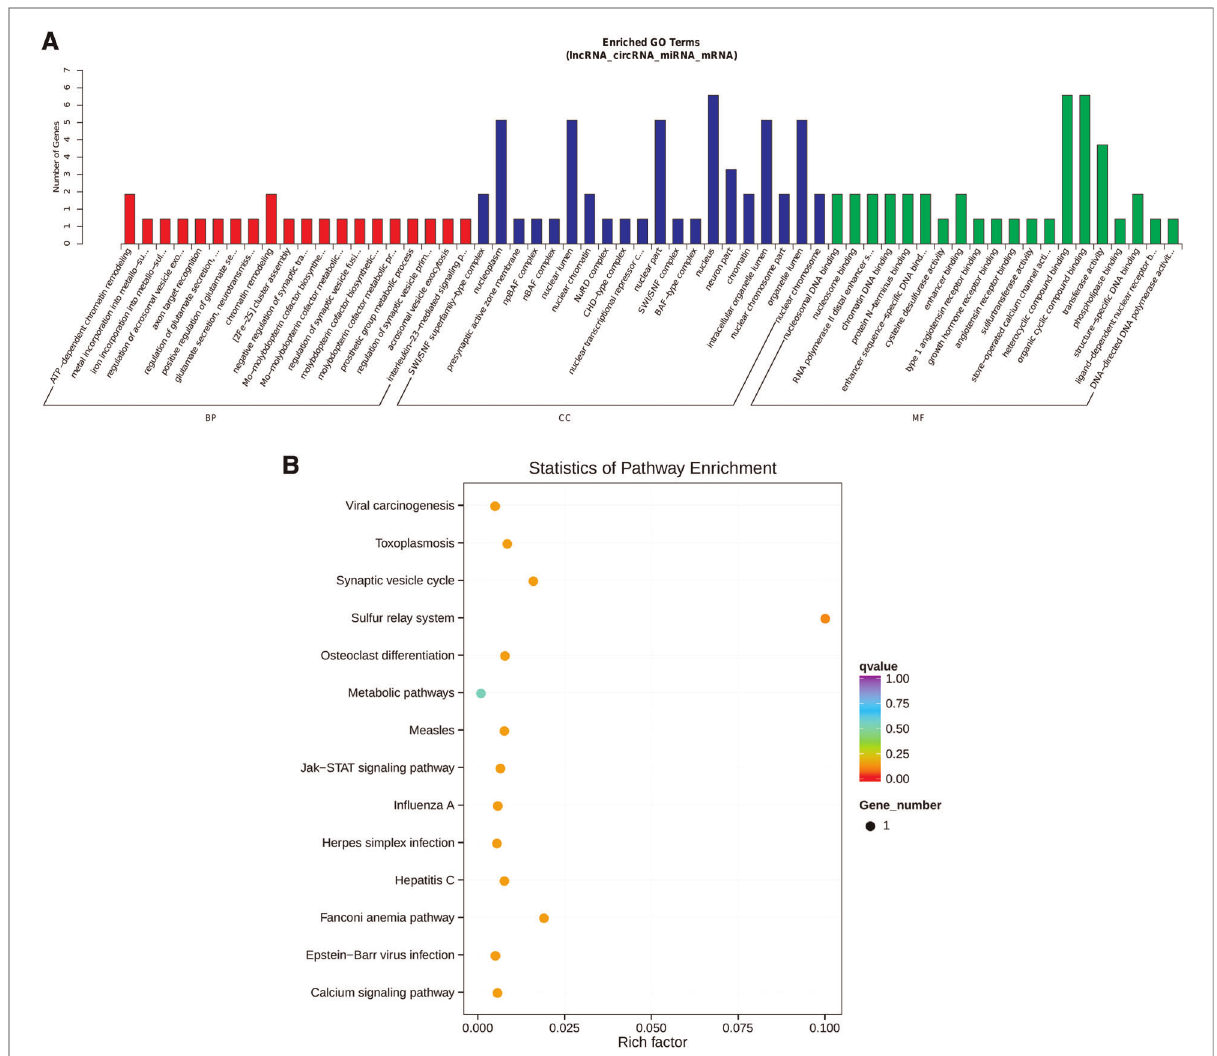
FIGURE 8 ceRNA regulatory network target gene enrichment analysis. ( A ) GO function enrichment bar chart of the top 20 enriched items. Abscissa denotes GO entry, BP, biological process; CC, cellular component; MF, molecular function represented by different color bars; ordinate is the number of genes enriched by GO entry. ( B ) KEGG pathway enrichment bubble